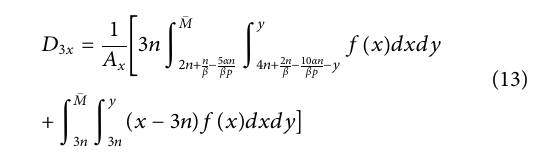
FIGURE 4 Users who do not choose any